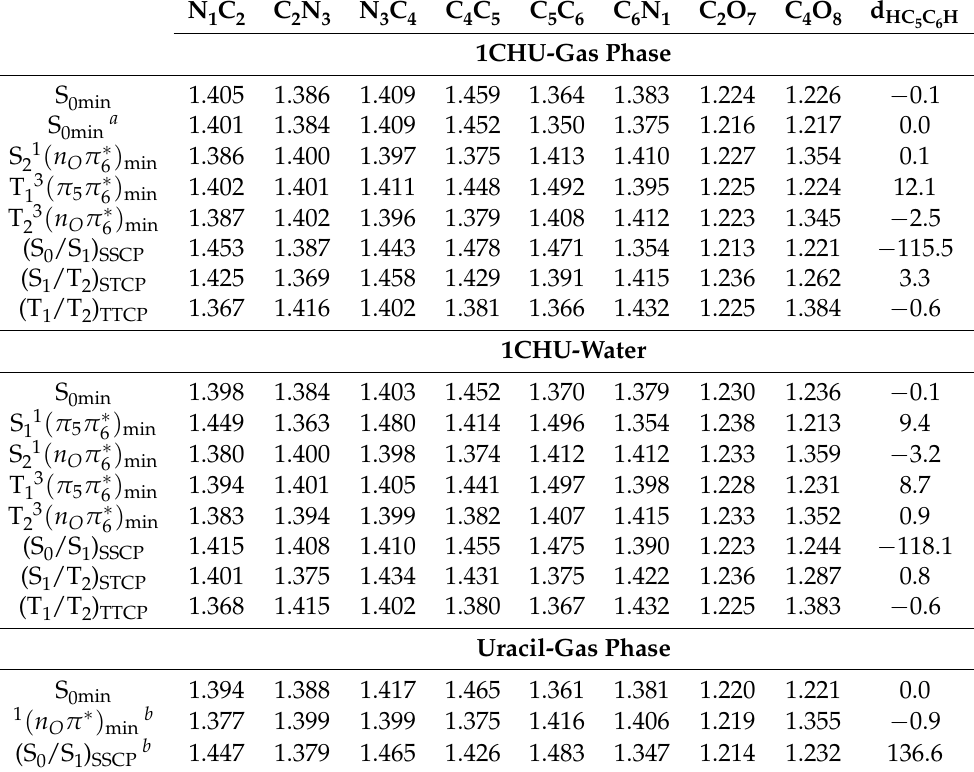
Table 1. Main atomic distances (in Å) and dihedral angle d HC geometries, in gas phase and water (as described by the Polarized Continuum Model, PCM), opti- mized at the MS-CASPT2(12,9)/cc-pVDZ level of theory. Other theoretical results and corresponding values for uracil are displayed for